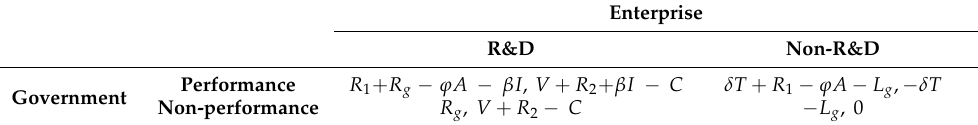
Table 1. Revenue matrix of “government–enterprise” parties considering public